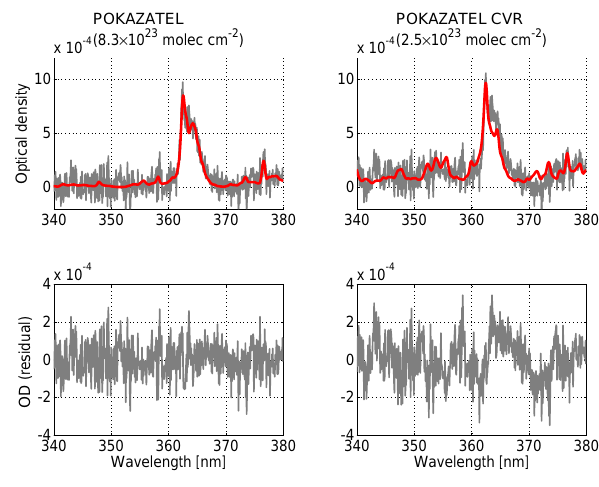
Figure 7. Two MAX-DOAS fits of the same measurement spec- trum from M91 showing the detection of water vapour absorptions at 363nm using two different DMSs (see Sect. 4.3). In order to re- duce residual noise, the fit is using four spectra with a total exposure time of 240s recorded on 22 December 2012, starting at 17:59UTC at 15 ◦ 31 (cid:48) S, 75 ◦ 36 (cid:48) W at a telescope elevation of 3 ◦ . The POKAZA- TEL (CVR) line list shows a 20% larger residual than POKAZA- TEL, whose shape fits the observed optical density